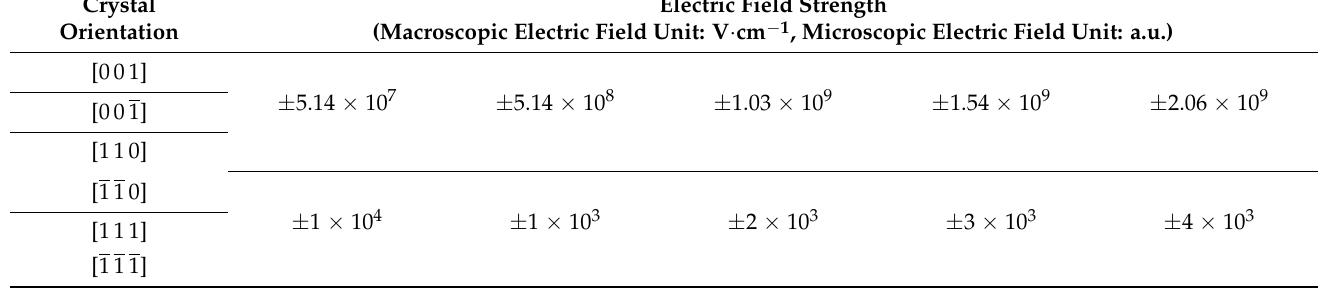
Table 2. Parameters of applied electric field in 3 crystallographic directions of diamond.